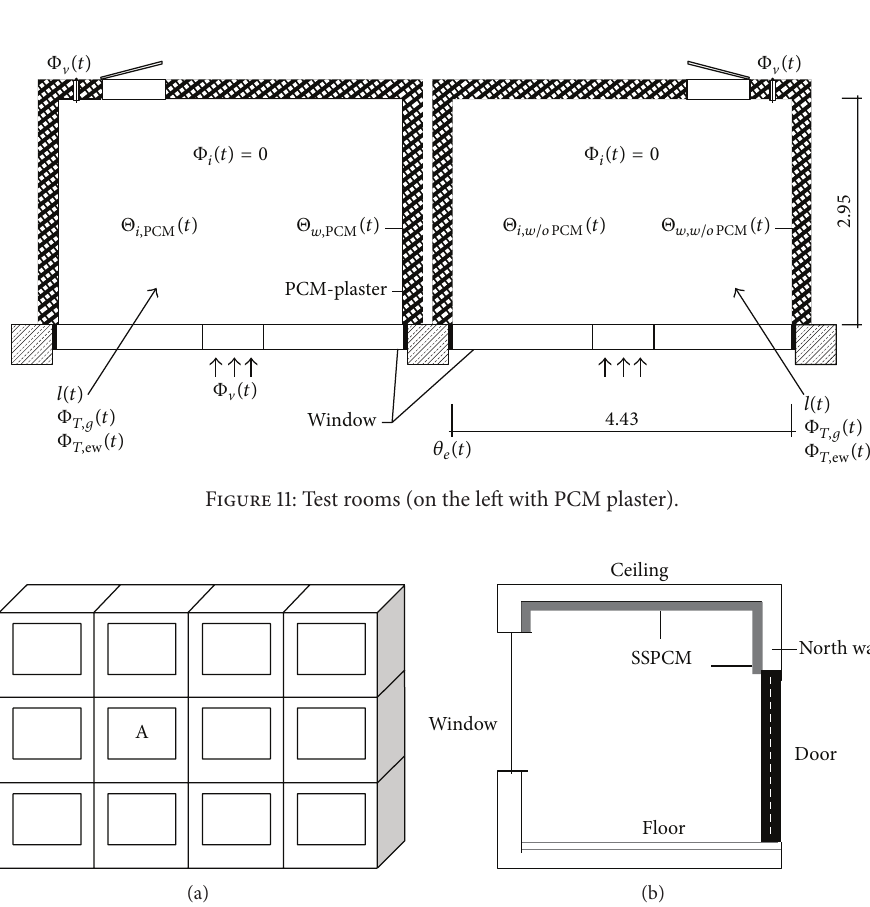
Figure 12: Schematic of the simulated room: (a) location of the simulated room A in the building and (b) profile of the room A with